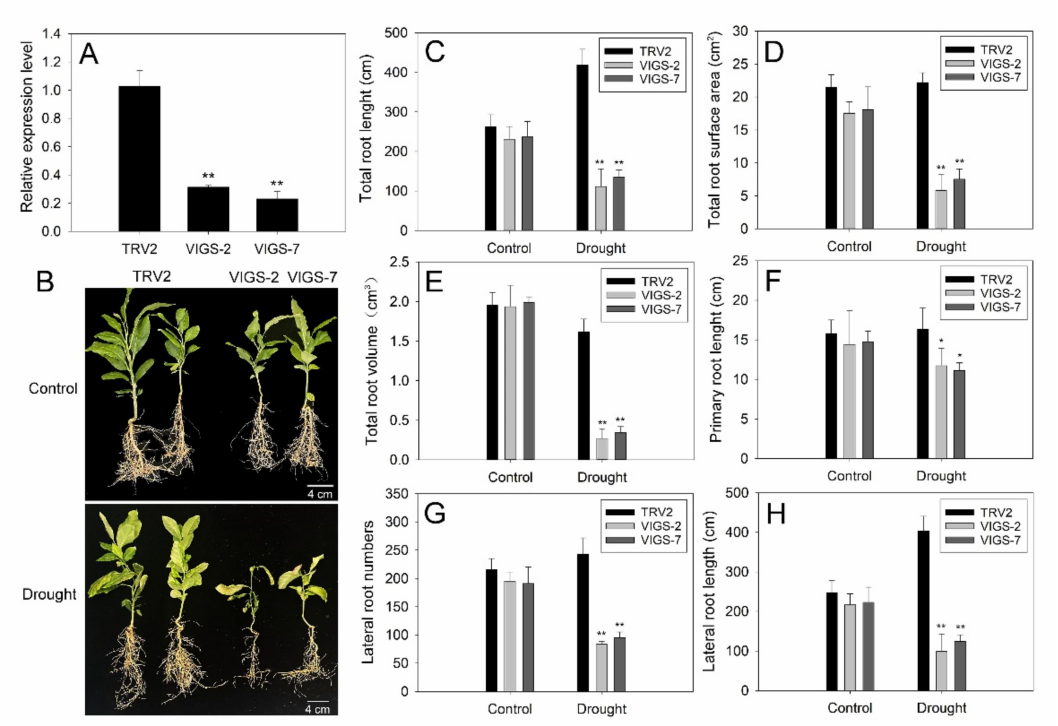
Figure 6. Drought tolerance analysis of PtrbHLH66 homolog silencing lemon plants. ( A ) Expression of PtrbHLH66 homolog in the TRV2 and two VIGS lemon lines (VIGS-2 and VIGS-7). Comparison of ( B ) phenotype and ( C ) total root lengths, ( D ) total root surface areas, ( E ) total root volumes, ( F ) primary root lengths, ( G ) lateral root numbers and ( H ) lateral root lengths between the TRV2 and two VIGS lemon lines under normal growth condition (control) and drought (withheld from watering for 3 weeks) stress. All data are shown as the means ± SD calculated from three biological replicates. Asterisks indicate that the values in the two VIGS lemon lines are significantly different from that of the TRV2 plants (** p < 0.01, * p <